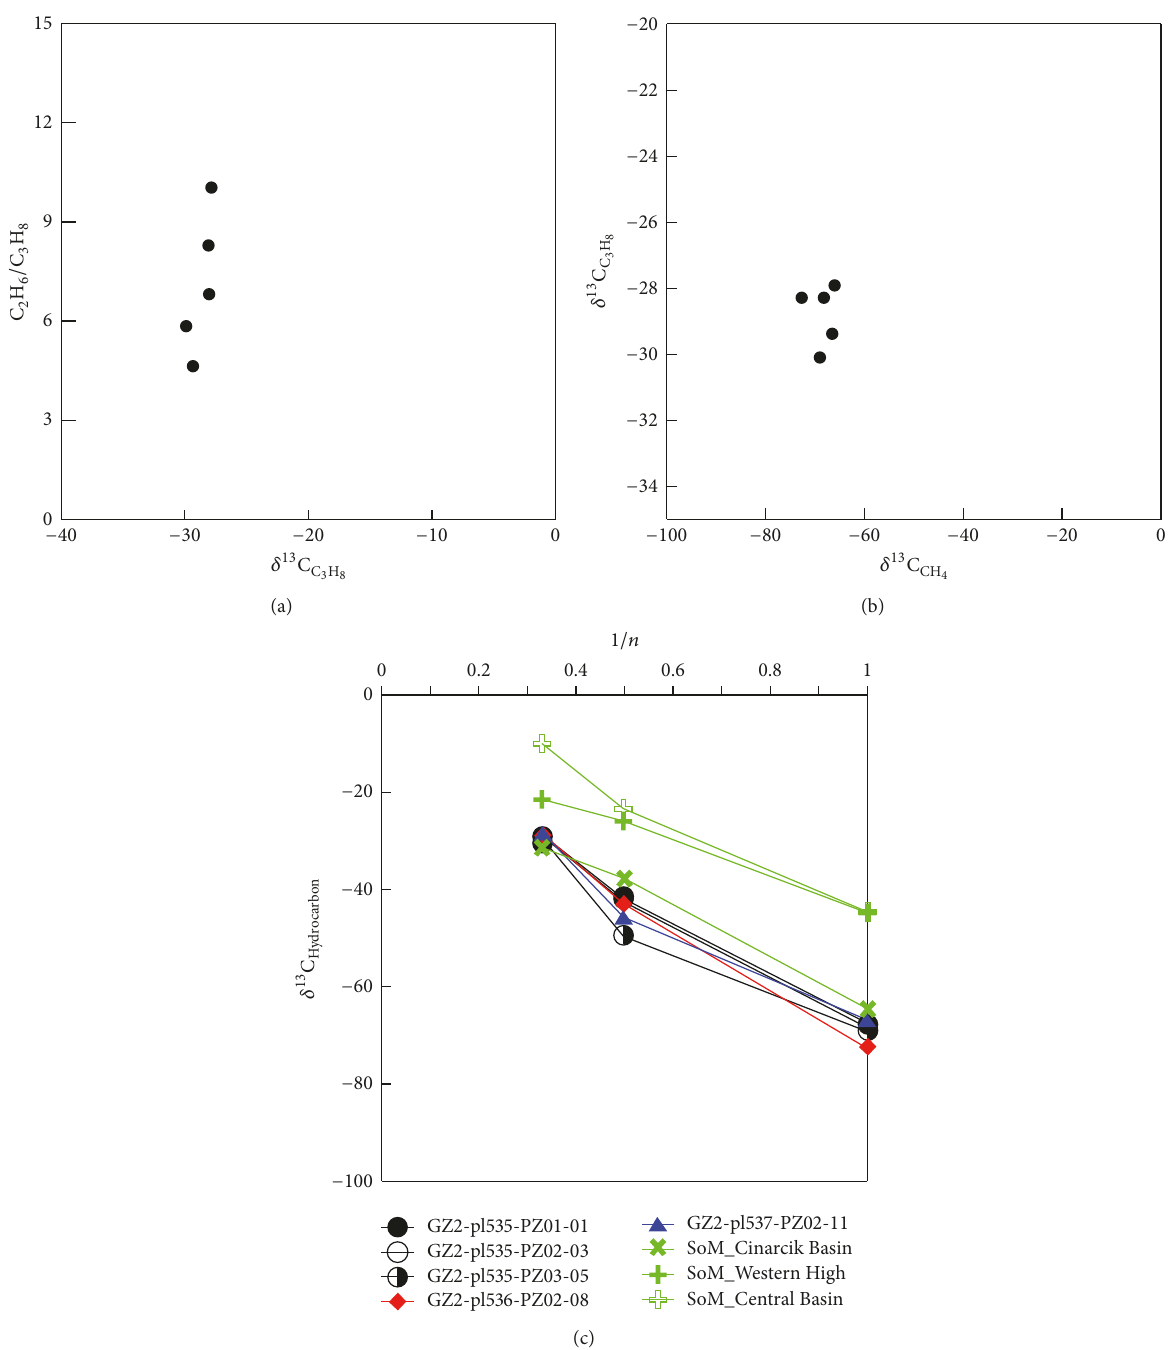
Figure 5: Diagrams for the study venting gases at the Aquitaine Shelf of (a) 𝛿 13 C C (modified after Prinzhofer and Deville, 2013) and (b) 𝛿 13 C C reciprocal number of carbon atom in methane, ethane, and propane versus their 𝛿 13 C for the study venting gases at the Aquitaine Shelf and other gas samples from the Sea of Marmara (after Chung et al.,